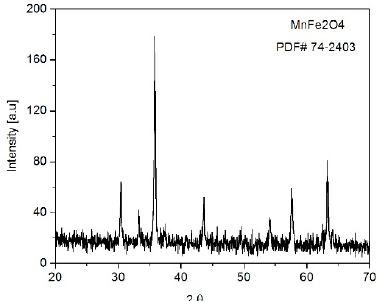
Figure 2. XRD pattern of manganese ferrite powder calcined at 150 °C for 24 h.